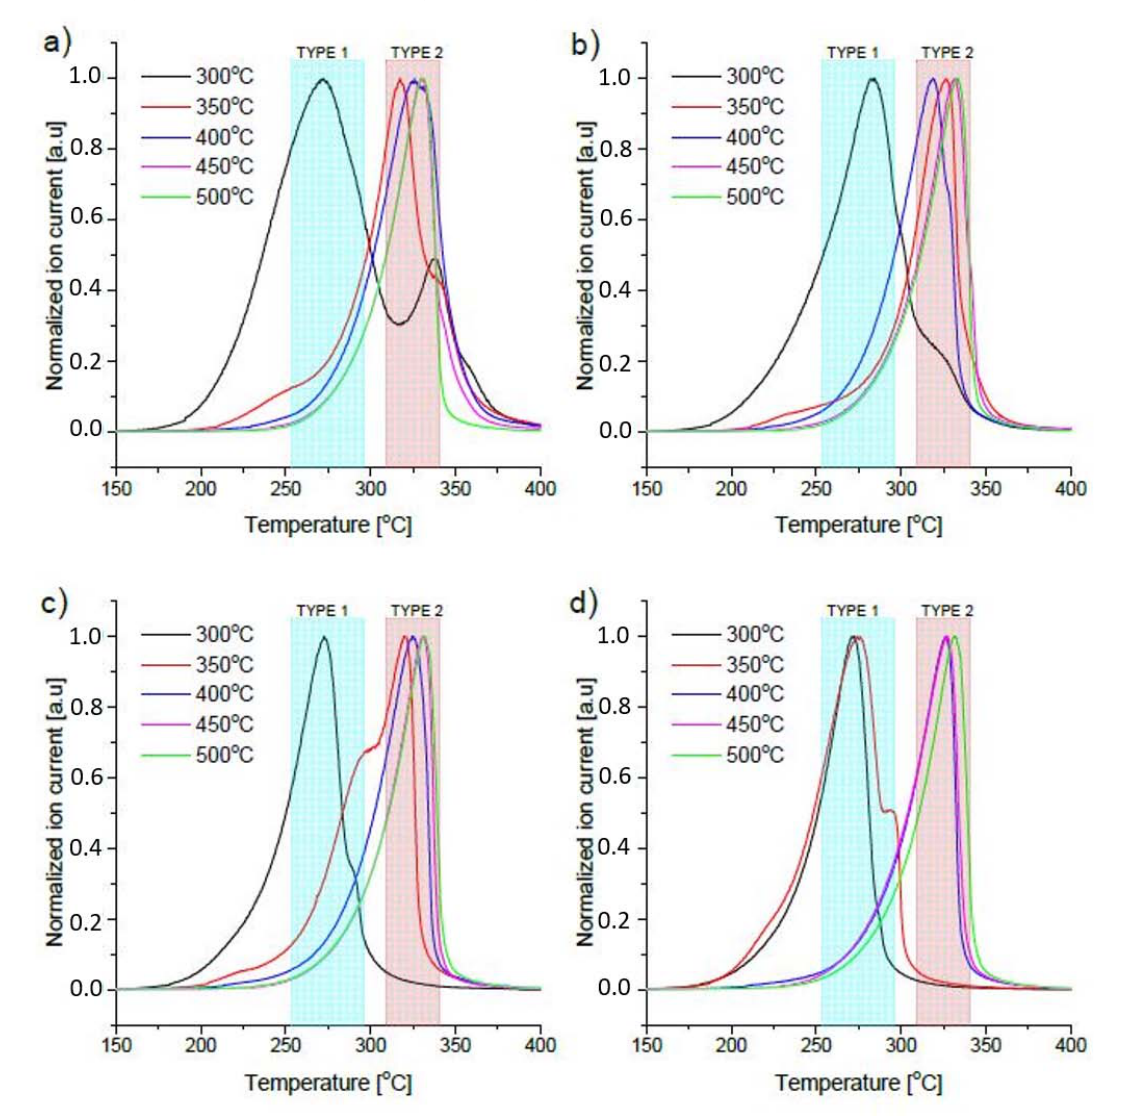
Figure 5. Thermal desorption spectra ( m / z = 2) after milling the MgH 2 + Fe mixture for ( a ) 30 min, ( b ) 1 h, ( c ) 2 h and ( d ) 3 h followed by sintering at different temperatures under hydrogen